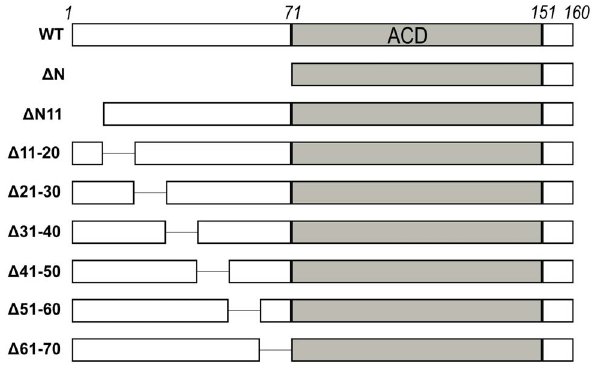
Figure 2. N-terminal 10-residue deletion mutants. Cartoon of the different HSPB6 constructs used in this work. The a -crystallin domain (ACD) is shown in grey. The numbers at the top of the cartoon correspond to the residue number at domain boundaries.